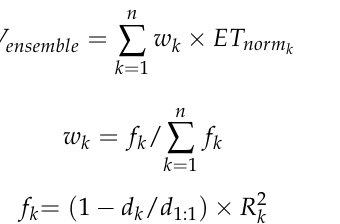
ensemble ET derived by a linear weighting method using the accuracy metrics of the root mean square error (RMSE), mean relative error (MRE) and relative RMSE